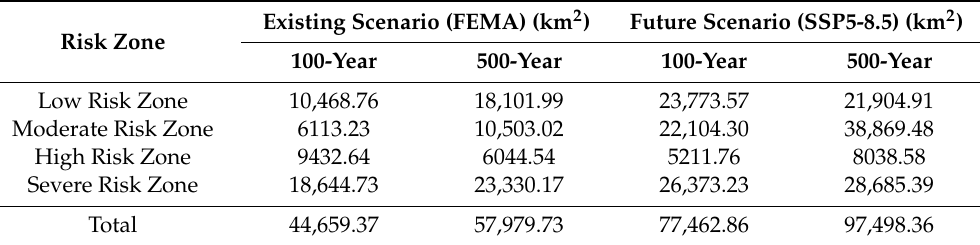
Table 5. Flood risk extent based on the zonal risk classification for 100-year and 500-year return period flood event for existing and future scenarios,